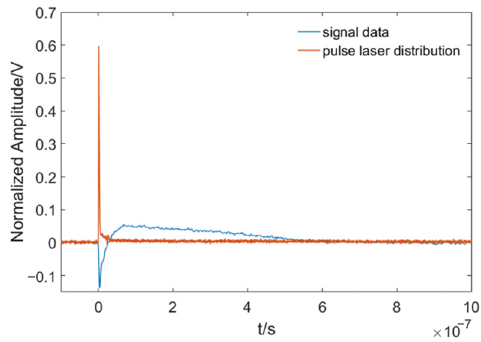
Figure 9. A representative experimental time-domain signal for the agarose gel and silicon interface.